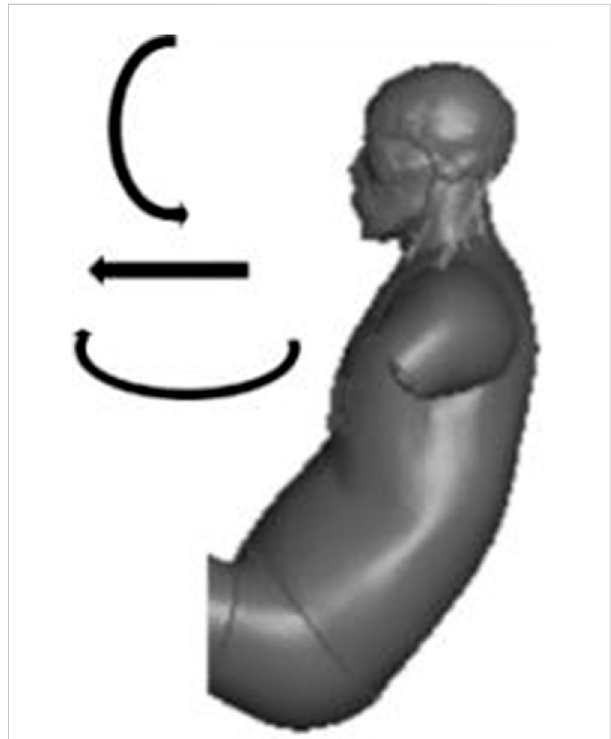
FIGURE 9 Occupant motion in pre-crash.